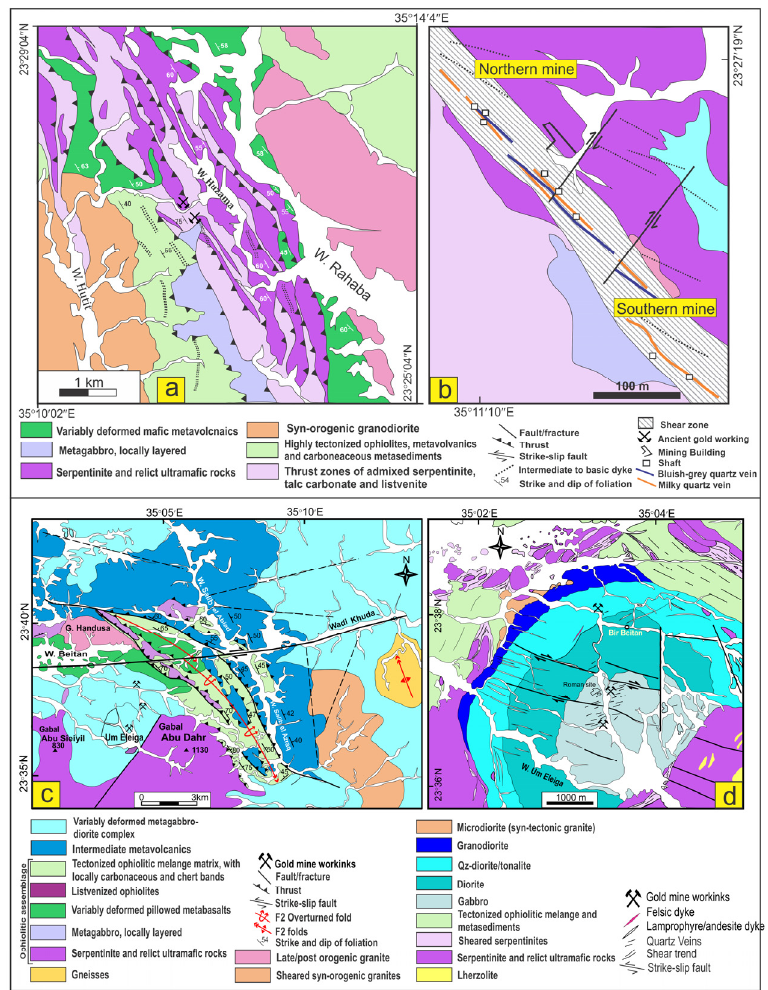
Figure 15. ( a ) Geological map of the Hutit gold mine and surroundings, (modified after from Hassan and El-Manakhly [82]; Zoheir et al. [12]), ( b ) Detailed geological map of the main lode in the northern mine and southern mine (modified after Zoheir et al. [12]). ( c ) Geological map of Abu Dahr ophiolite (modified from Ashmawy, [86]), and ( d ) Geological map of the Um Eleiga gold mine (modified from Zoheir et al. [41]).